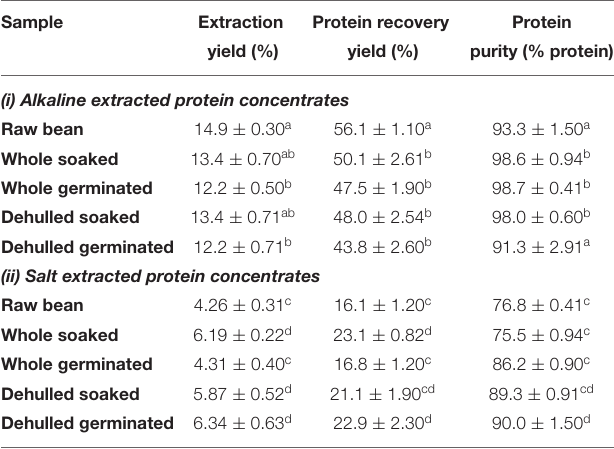
TABLE 2 | Protein extraction efficiency of untreated and pre-treated Yellow Eye bean protein concentrates prepared by alkaline and salt-extraction methods.